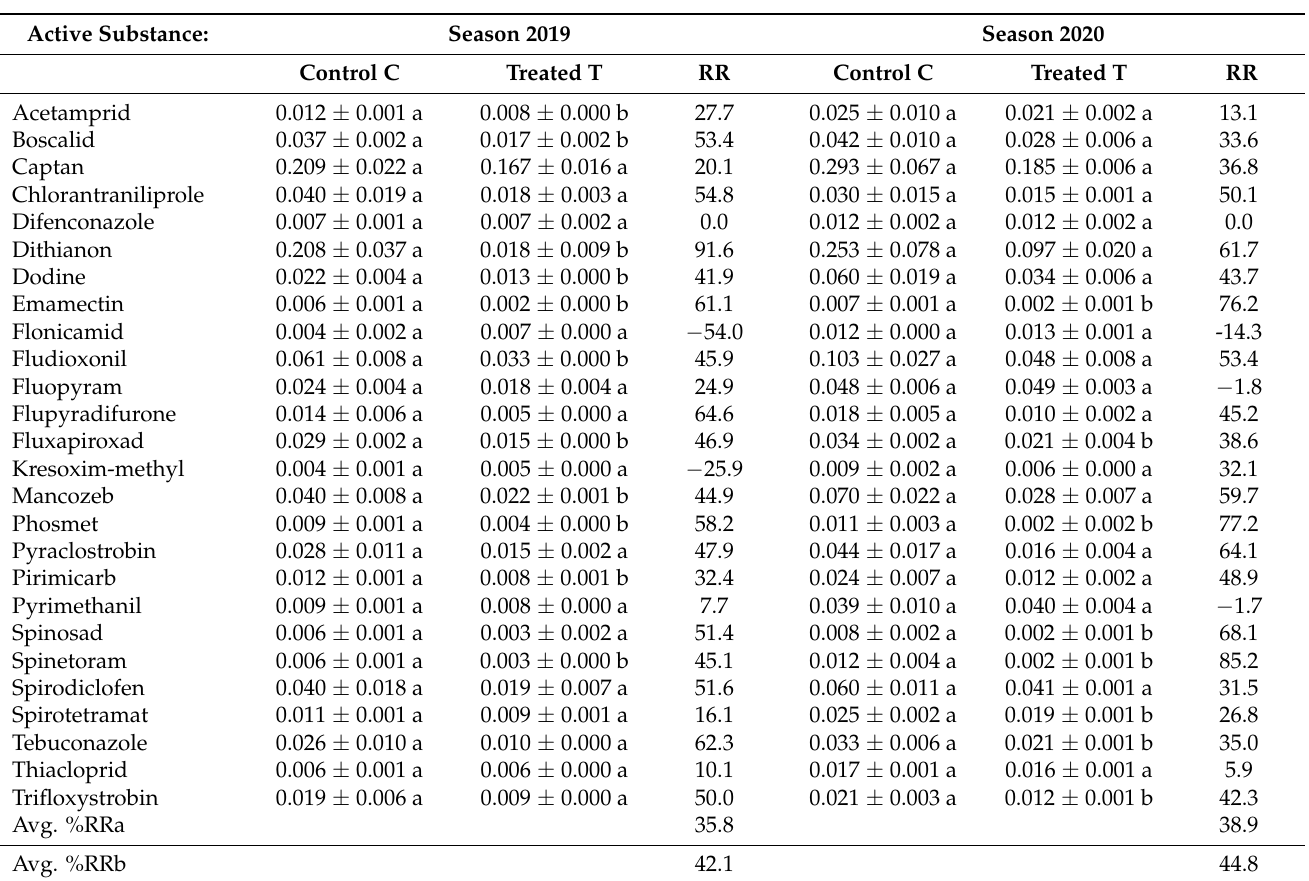
Table 4. Average concentration of pesticide residues ( ± SE) in apples at picking times (mg kg − 1 ) in relation to treatment with EM (effective microorganisms); four times preharvest at a rate of 10 L of EM Naturally ® /1000 L